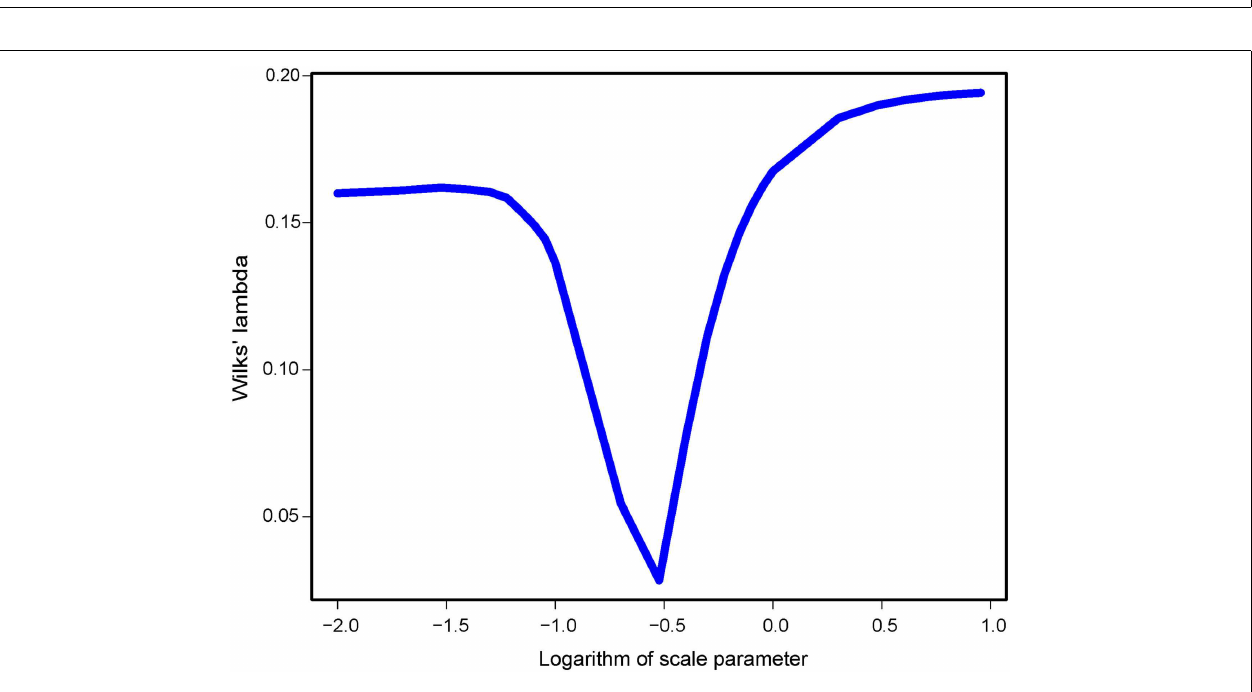
FIGURE 4 |Two discrete populations under equilibrium IBD. Plots of the first 2 maps for (A) PCA, (B) sPCA, (C) spFA, (D) SFA.